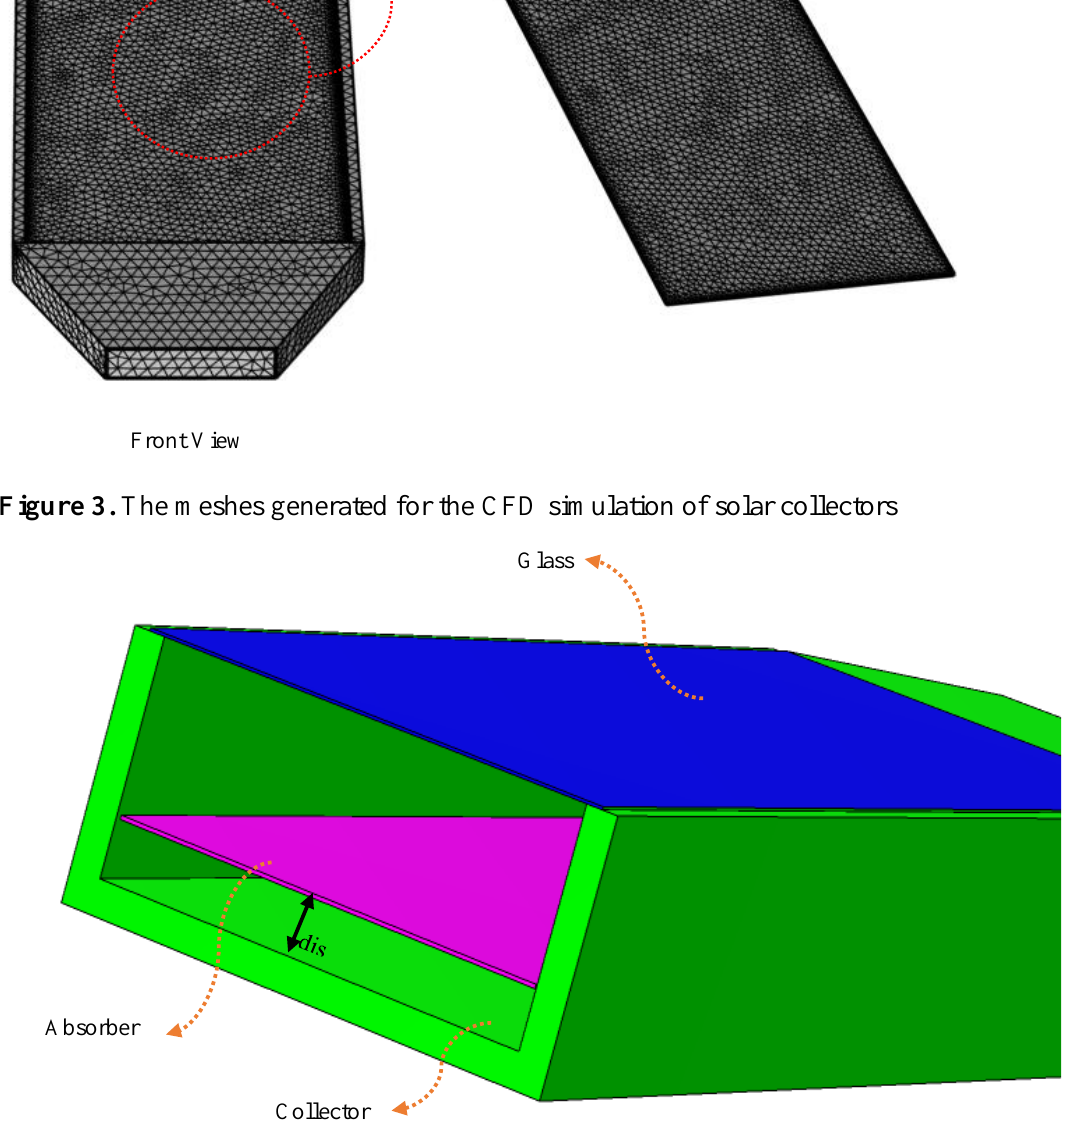
Figure 4. The location of the absorber plate relative to the collector bottom